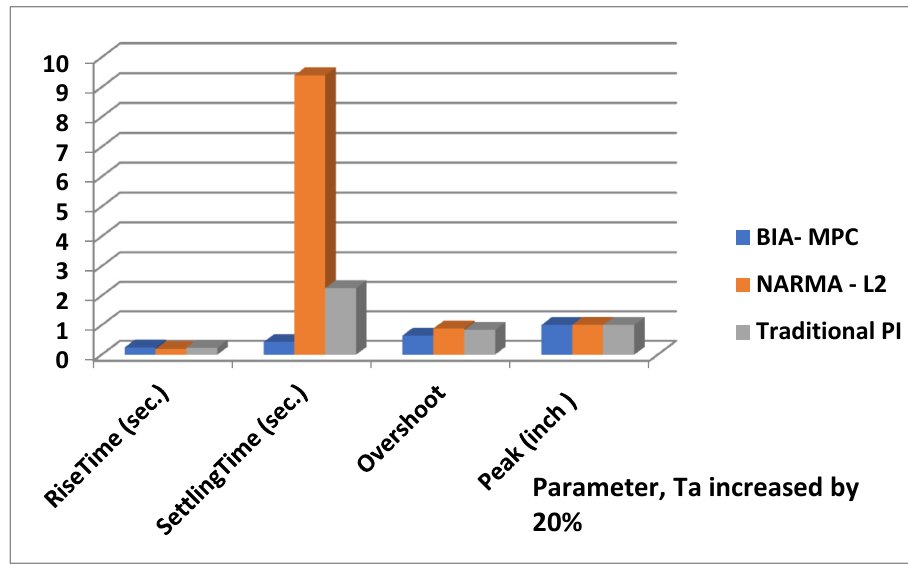
Figure 19. Chart of performance criteria in system perturbation by 20%.